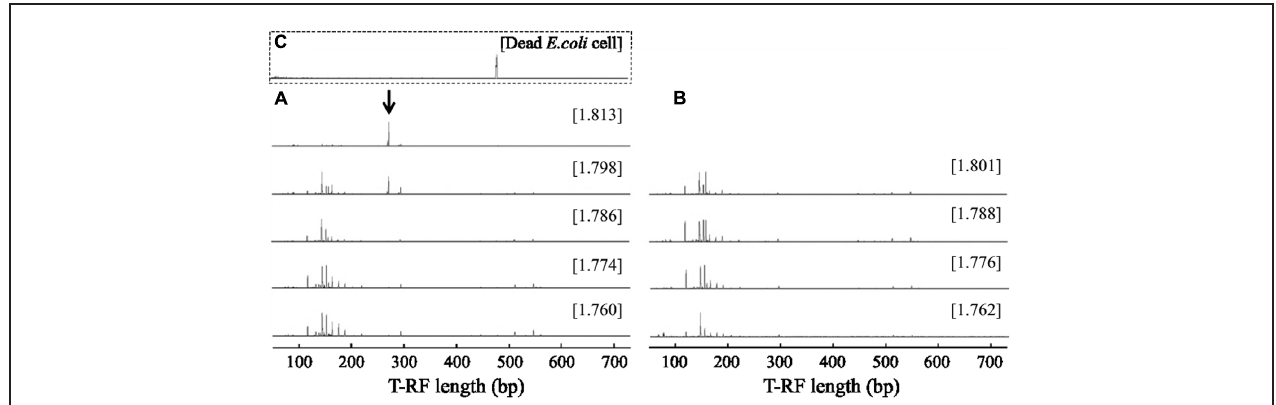
FIGURE 2 | Terminal restriction fragment length polymorphism (T-RFLP) fingerprints of bacterial 16S rRNA separated by isopycnic centrifugation from (A) 13 C-labeled and (B) unlabeled samples 2 h after addition of dead E. coli cell suspension. T-RFLP fingerprint of (C) the dead E. coli cell suspension is shown in the square with broken lines. The CsTFA BD (g ml − 1 ) of each fraction is shown in square brackets. The arrow indicates specific T-RFs observed in the heavy fraction of a 13 C-labeled sample.